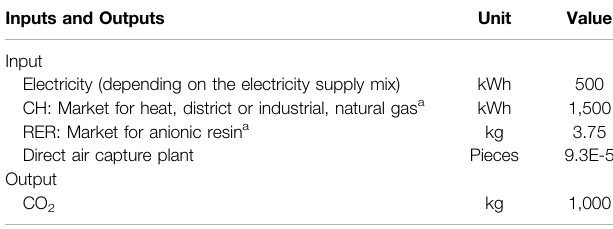
TABLE 4 | Operation of DAC to produce 1 t of CO 2